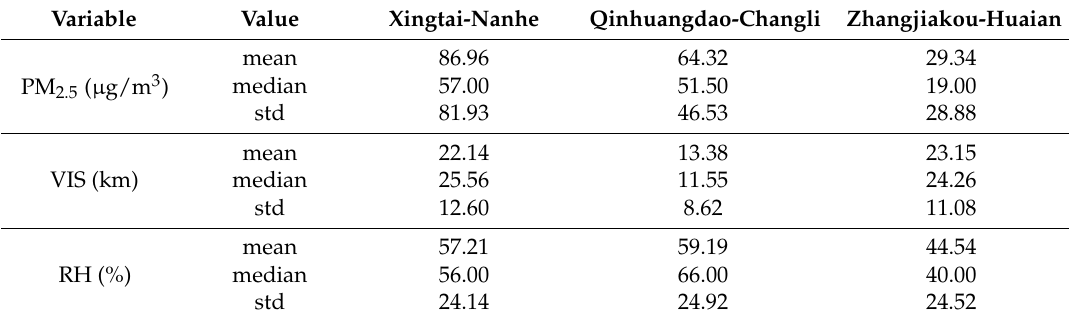
Table 1. Statistical hourly PM 2.5 data from January to June